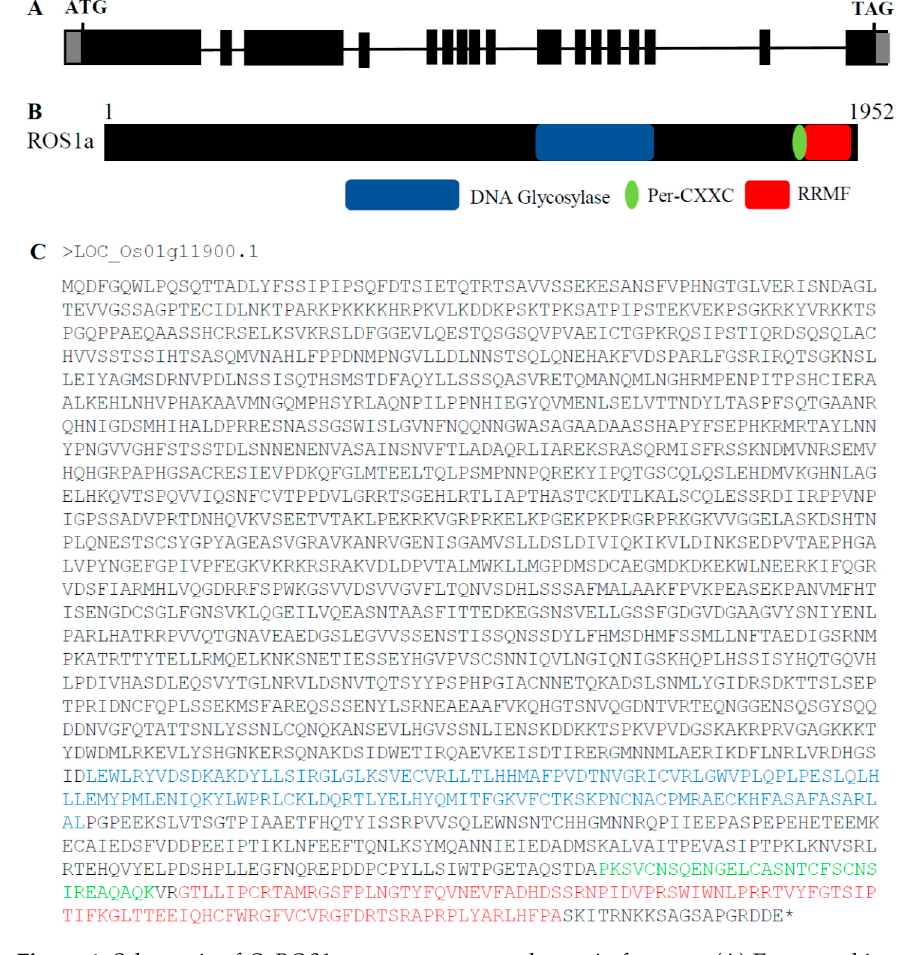
Figure 1. Schematic of OsROS1a gene structure and protein features. ( A ) Exons and introns of the OsROS1a gene are denoted as black blocks and lines, respectively. The translation initiation codon (ATG) and termination codon (TAG) are shown. ( B ) The protein structure of the OsROS1a gene. The open reading frame (ORF) is 1952 amino acid residues. ( C ) The protein sequences of the OsROS1a gene. The DNA glycosylase, Per-CXXC and RRMF domains are shown in blue, green and red colors, and all others showed in black.